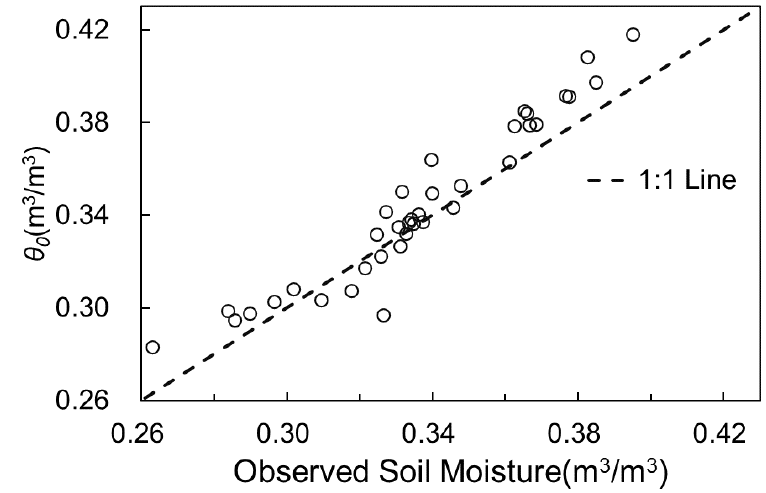
Figure 5. Relationship between fitted θ 0 and measured initial soil moisture (each circle corresponds to an experimental scenario).